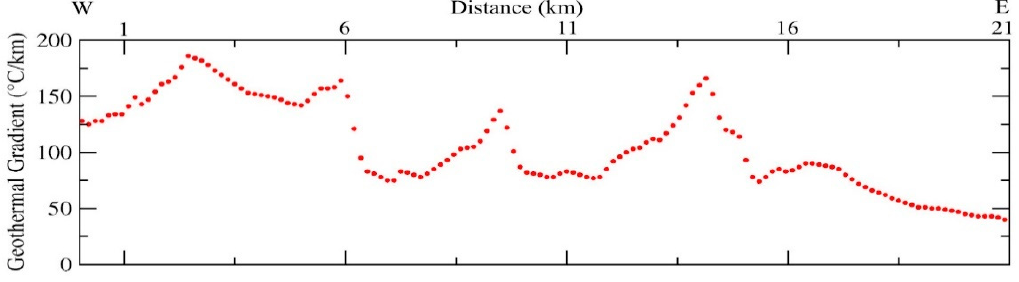
Figure 5. Geothermal gradient of the seismic profile RC2901-751. See text for